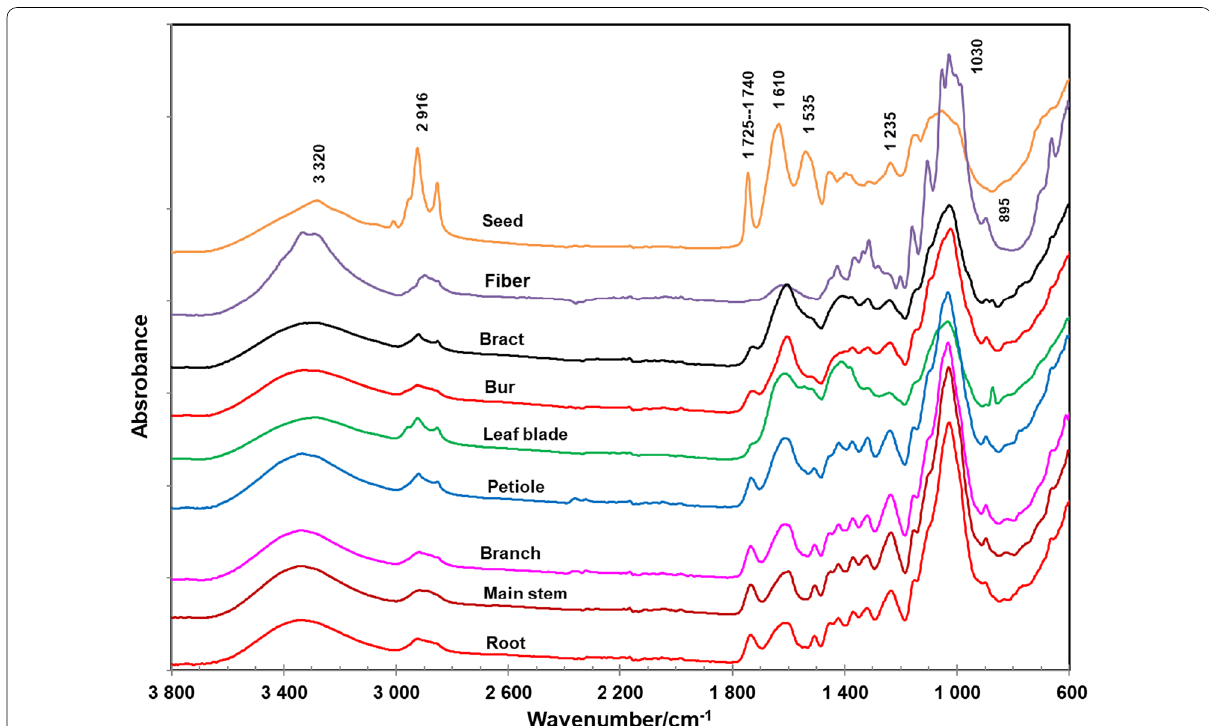
Fig. 5 ATR FT-IR spectra of nine different cotton organs and tissues collected from cotton plants at the maturation